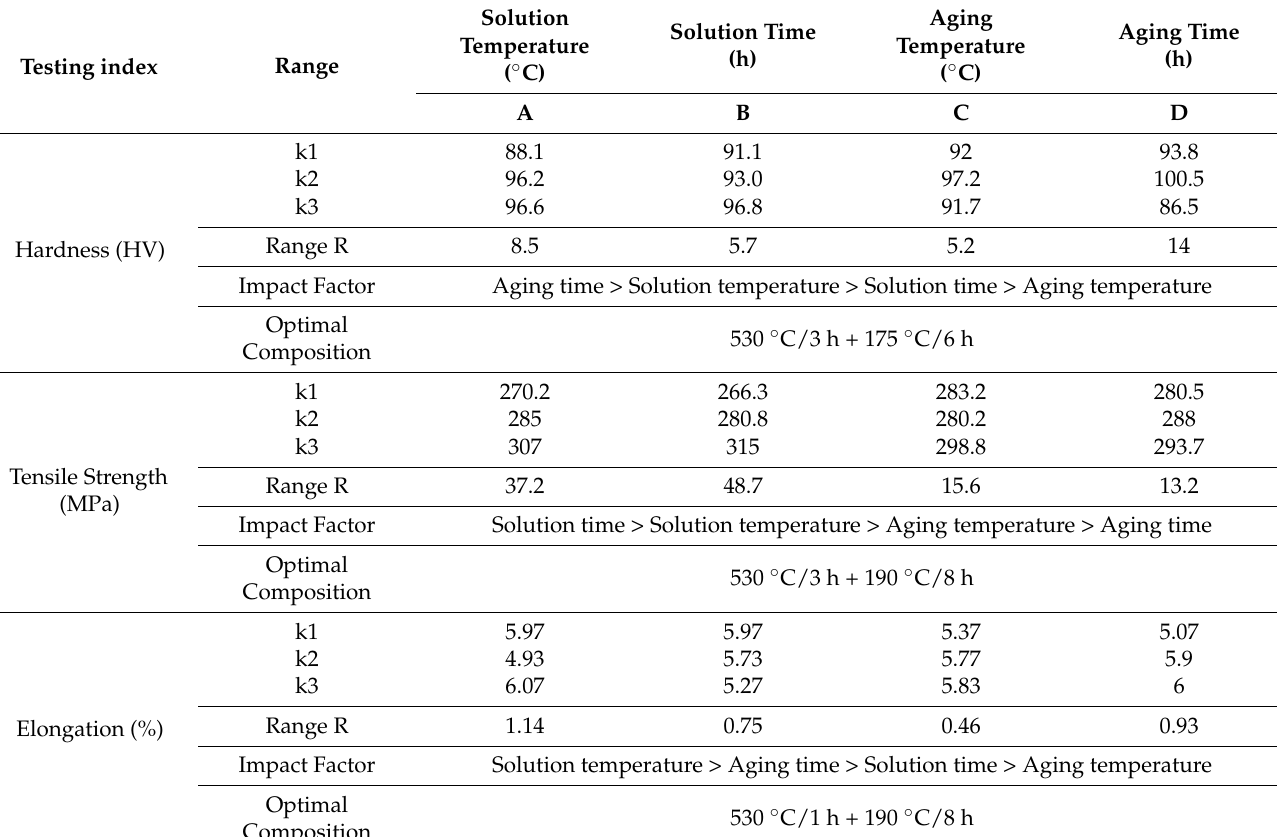
Table 4. Range analysis of the orthogonal test